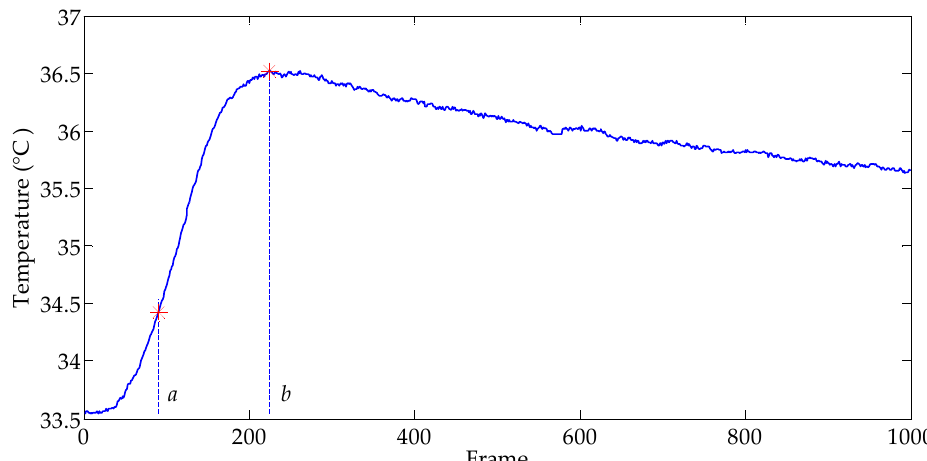
Figure 9. The surface temperature of the shallower defect with frame.